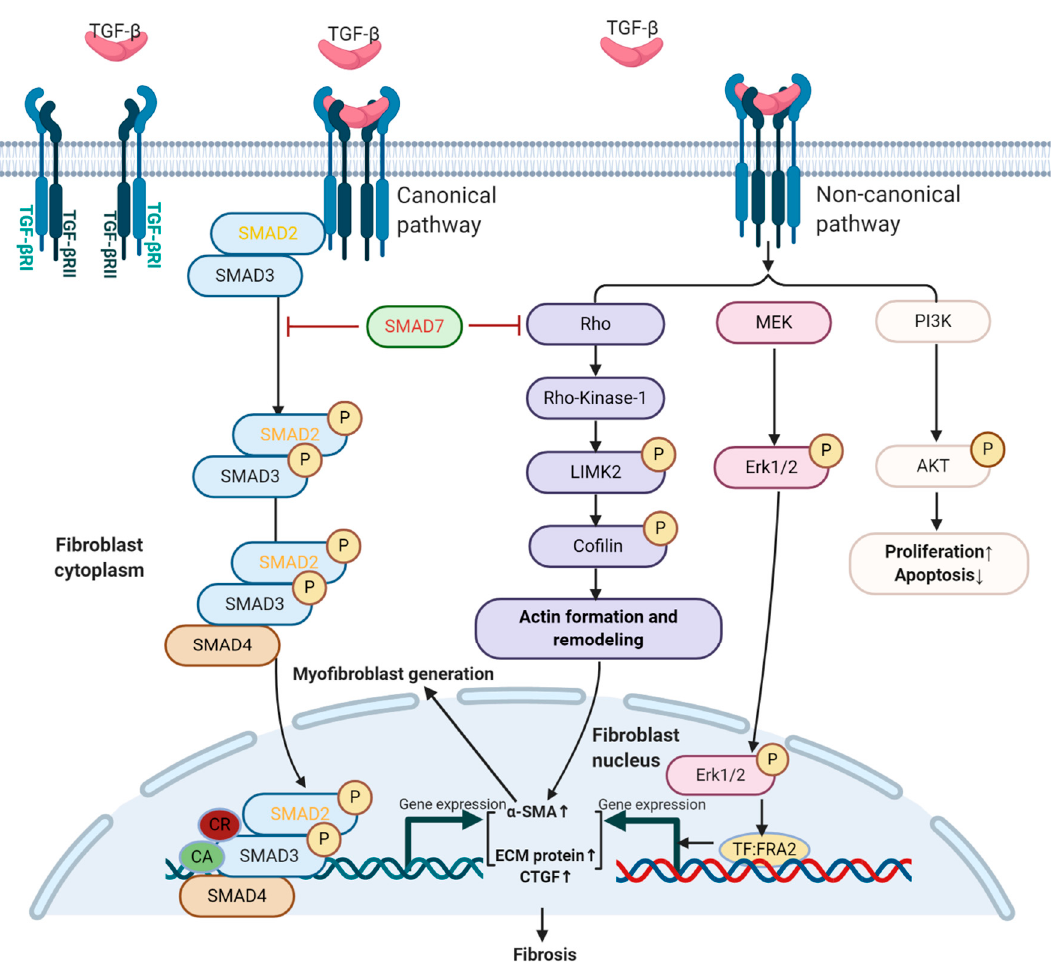
Figure 1. TGF- β signaling in fibroblasts. TGF- β signals start when the TGF- β ligand binds to TGF- β type II receptors (TGF- β RII), and phosphorylates TGF- β type I (TGF- β RI), activating various intracellular signaling cascades. Intracellular pathways activated by TGF- β include the canonical SMAD2 / 3 pathway and non-canonical TGF- β pathways, such as Rho-associated coiled-coil containing protein kinases (ROCKs), MAP kinases (ERK), and PI3K / AKT, which can regulate myofibroblast generation, fibroblast proliferation / apoptosis, and extracellular matrix (ECM) protein production. Activated small mothers against decapentaplegic homolog (SMAD) proteins or phosphorylated mediators of non-canonical signaling translocate into the nucleus and interact with DNA by transcription factors (TF), co-activators (CA, such as p53), and co-repressors (CR) to regulate gene expression, resulting in increased myofibroblast generation, elevated ECM protein production and increased pro-fibrotic factor connective tissue growth factor (CTGF) to promote fibrosis. The black characters / arrows indicate mediators / processes that promote fibrosis, and red characters indicate inhibitors of TGF- β signaling-mediated fibrosis in fibroblasts.